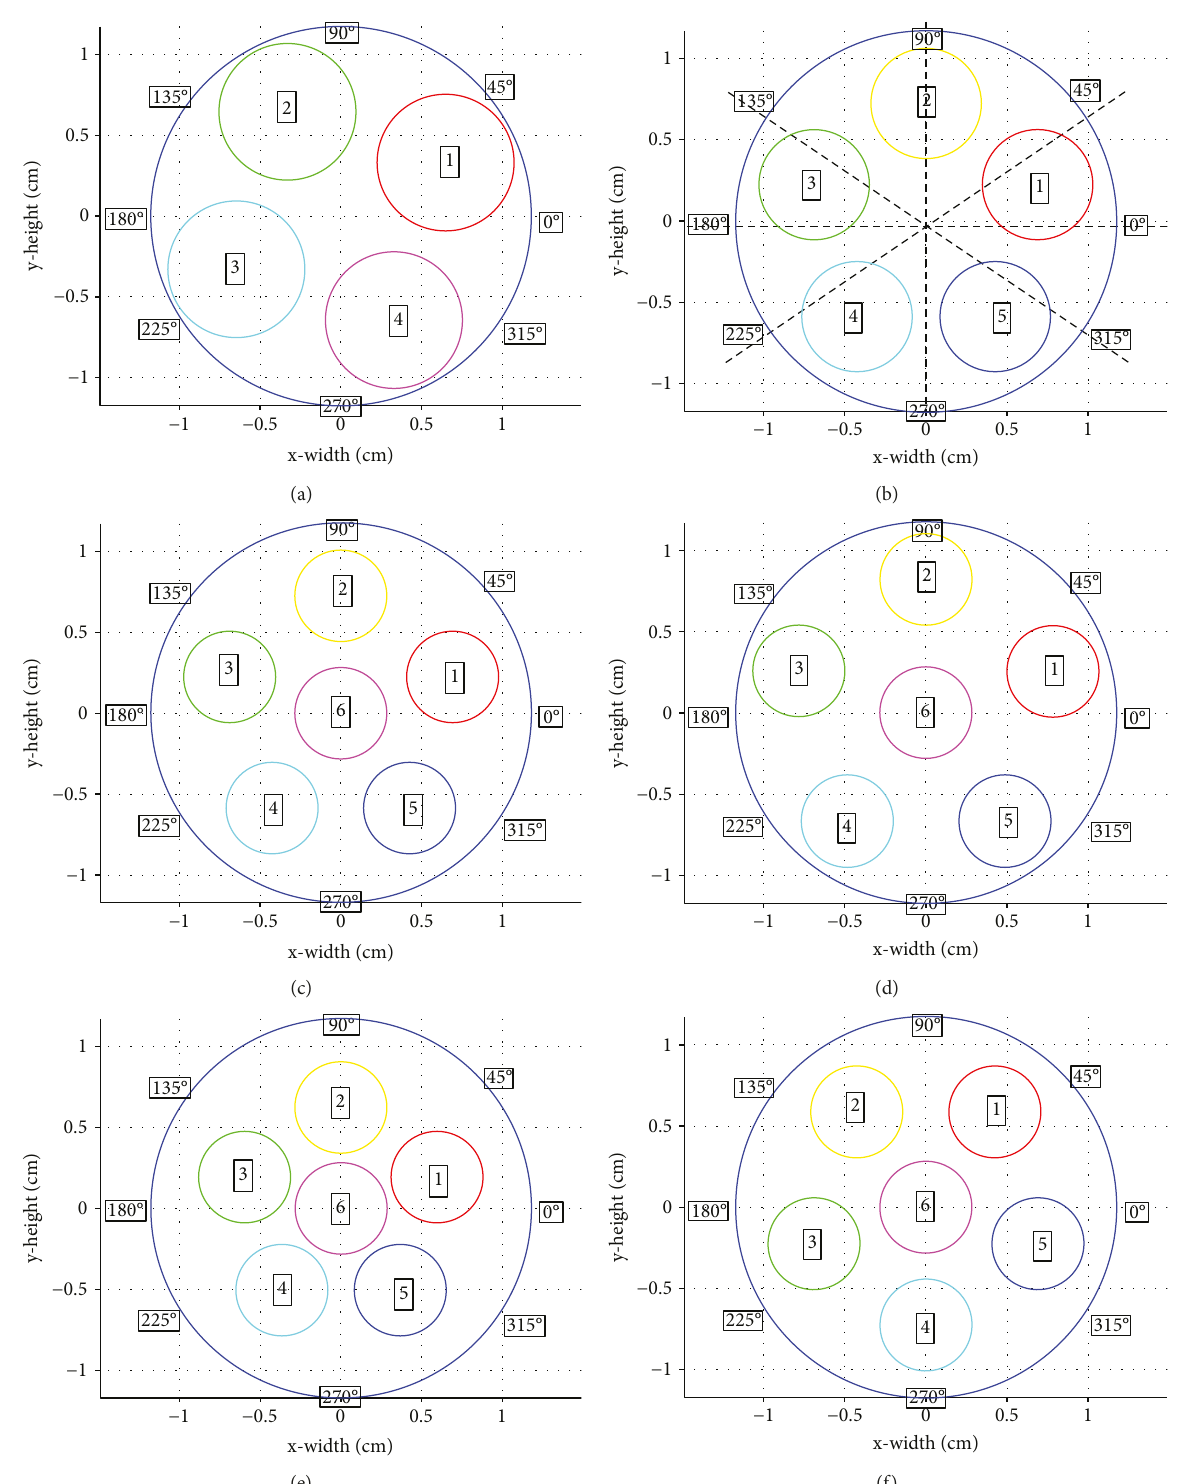
Figure 5: Diagram of the multitubular con fi gurations analyzed: (a) four tubes in a square; (b) fi ve tubes in pentagram disposition; (c) six tubes in a pentagram disposition with central tube; (d) six tubes with increased distance; (e) six tubes with decreased distance; (f) six tubes rotated by π /5